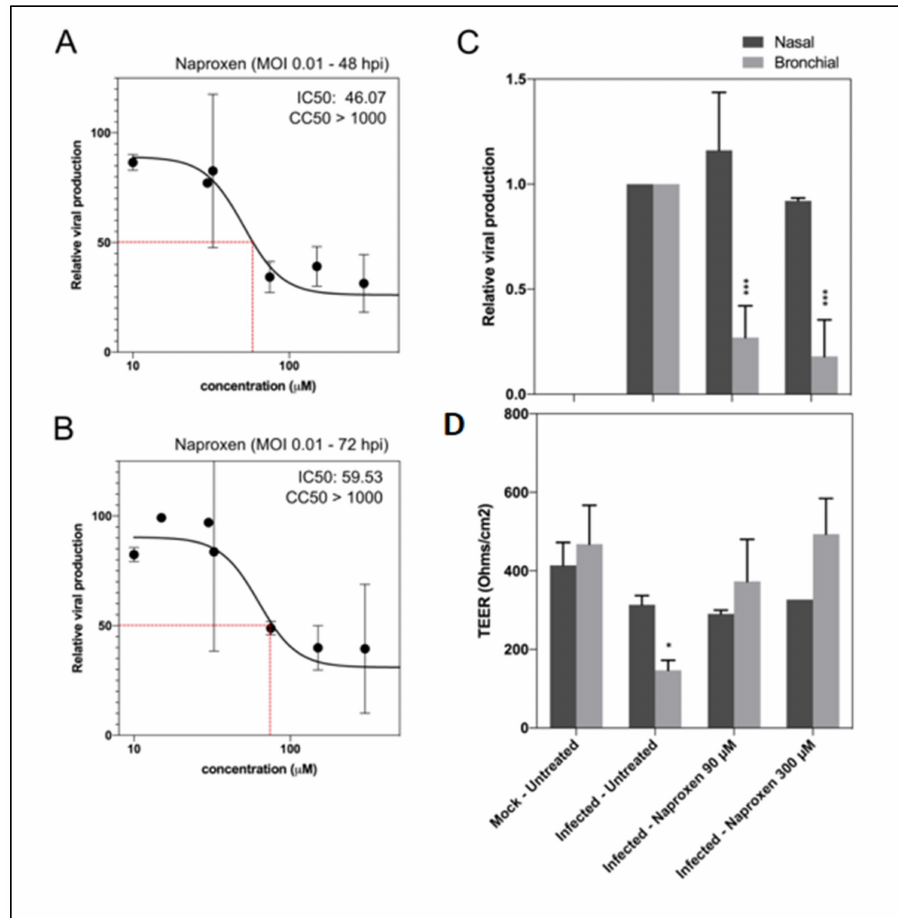
Figure 6. Naproxen inhibits SARS-CoV-2 infection in Vero E6 cells and in HAE. ( A , B ) Dose–response curves of naproxen at 48 and 72 hpi in infected Vero E6 cells. Cells were infected at MOI 0.01 with SARS-CoV-2 and then treated 1 h postinfection with a large range of concentration of naproxen; ( C ) Relative intracellular viral genome quantification and ( D ) trans-epithelial resistance (TEER in Ohms/cm 2 ) between the apical and basal poles in nasal and bronchial HAE at 48 hpi. Results are expressed in relative viral pro- duction compared to the infected untreated control and relative TEER compared to t = 0 (before infection). *** p < 0.001 and * p < 0.05 compared to the infected untreated (viral titers) or uninfected (TEER) groups by Student’s t -test. Data are representative of three independent